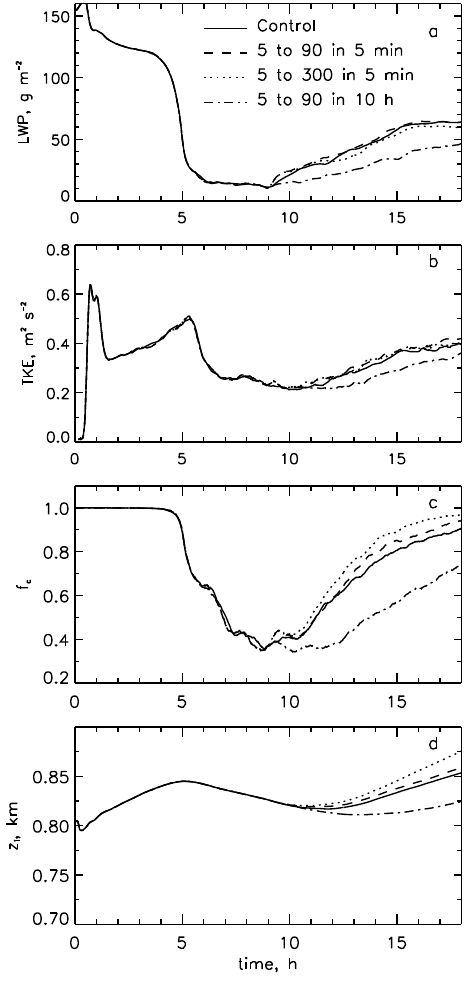
Figure 9. Simulations testing the importance of N for recovery of the closed-cell state for control case set up with variations. Simu- lations prior to t = 9h are the same (slight differences are due to different machine compilers and processors). After t = 9h, N in- creases to 90mg − 1 within 2h as in Fig. 1 (solid line, control); N recovers to 90mg − 1 within 5min (dashed line); N recovers to 300mg − 1 within 5min (dotted line); and N recovers to 90mg − 1 within 10h (dash-dotted